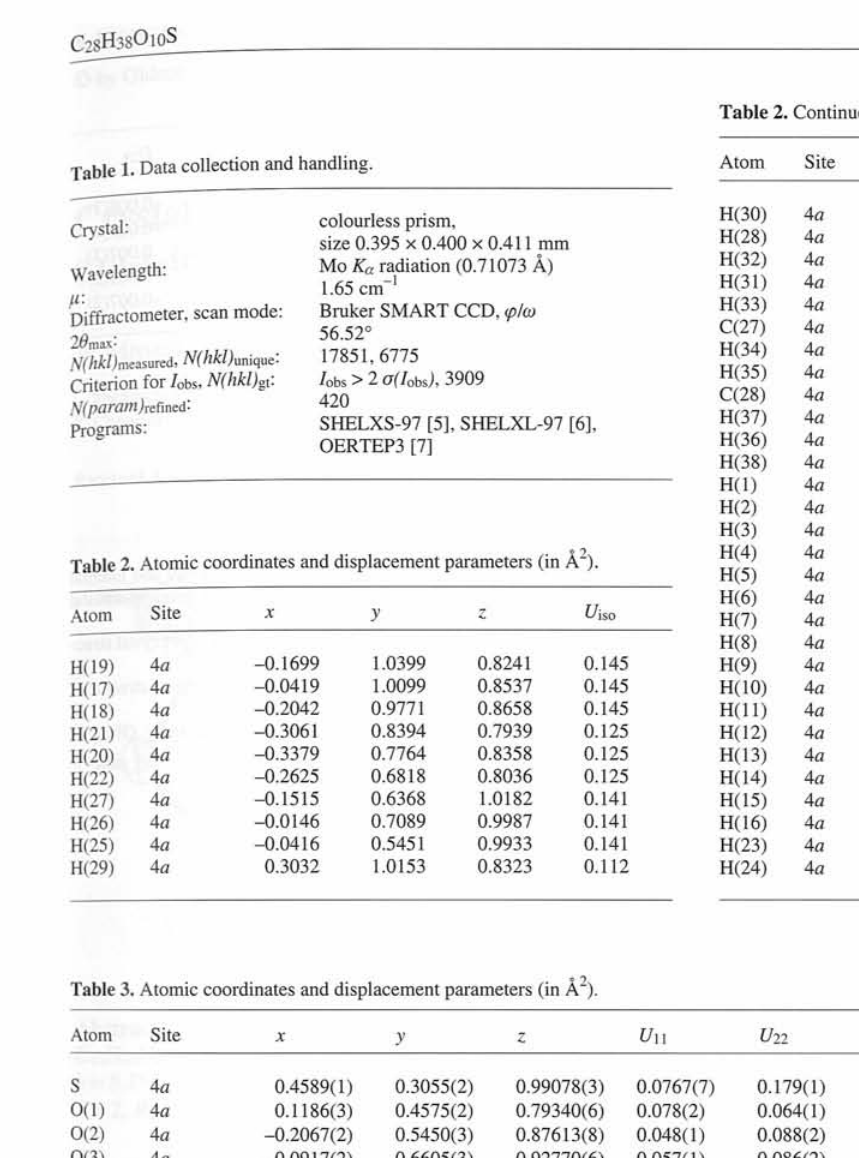
Table 3. Atomic coordinates and displacement parameters (in Â 2